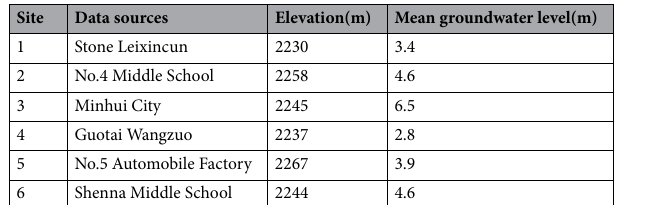
Table 1. Detailed data on study